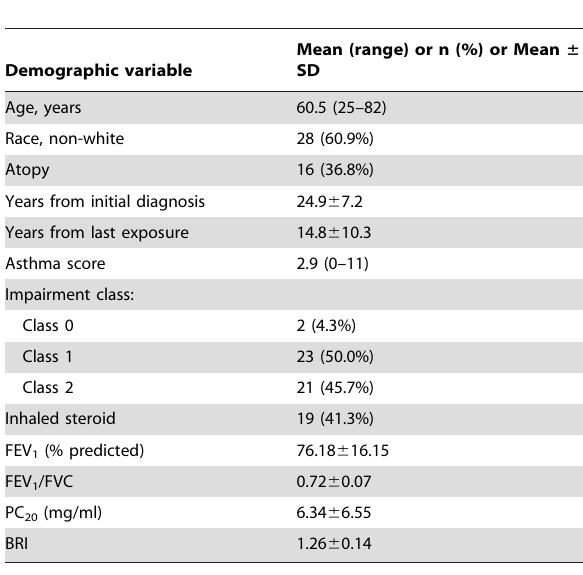
Table 1. Demographic data of participants, their lung function and methacholine challenge test results (n =46).